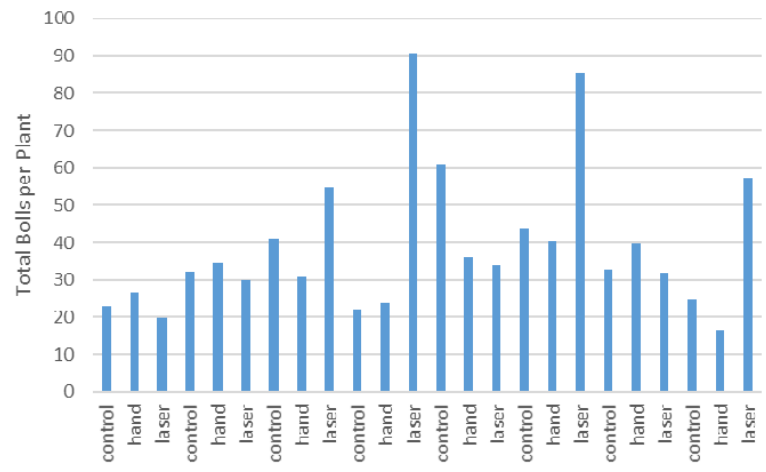
Figure 11. Boll counts for greenhouse-grown plants utilizing small 4 L pots.